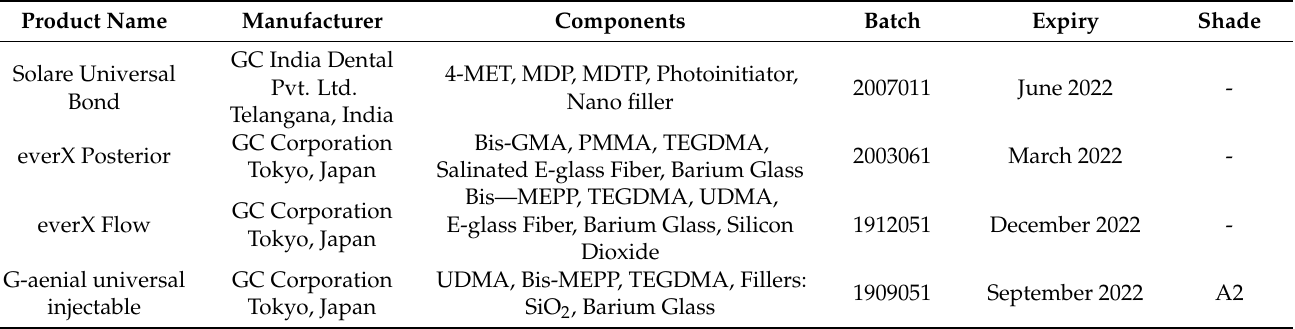
Table 1. Details of the materials used in this